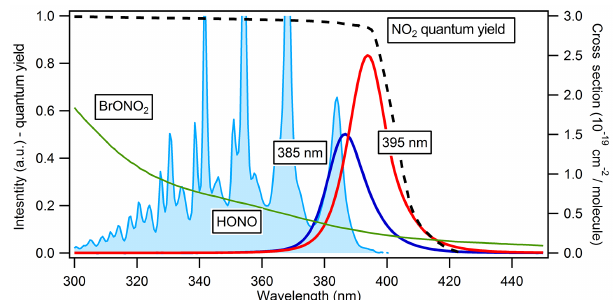
Figure 1. The measured spectral output of two UV-LED elements, nominally 385nm output in dark blue and 395nm in red. The HONO absorption spectrum is shown in light blue, whilst the NO 2 quantum yield is shown in dashed black. The absorption cross sec- tion of BrONO 2 is shown in